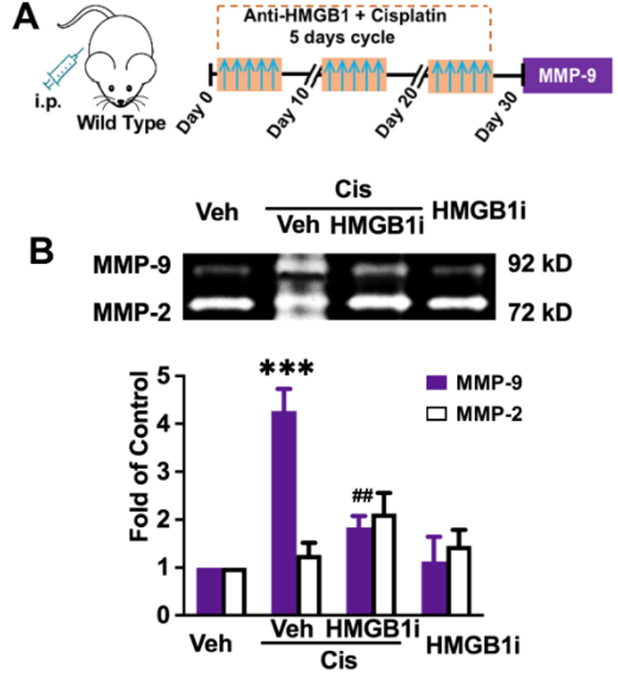
Figure 3. Effects of systemic HMGB1 neutralization on the cisplatin-induced increase of MMP-9 in the hippocampus. ( A ) Behavior paradigm. ( B ) The effect of anti-HMGB1 on cisplatin-induced increase of MMP-9 in the hippocampus. Up, the sample graph of Gelatin zymography, down, the analysis data. Significant difference was revealed following one-way ANOVA ( p *** < 0.001 vs. vehicle, p ## < 0.01, vs. cisplatin + vehicle group. Turkey post hoc tests). n = 3~4.